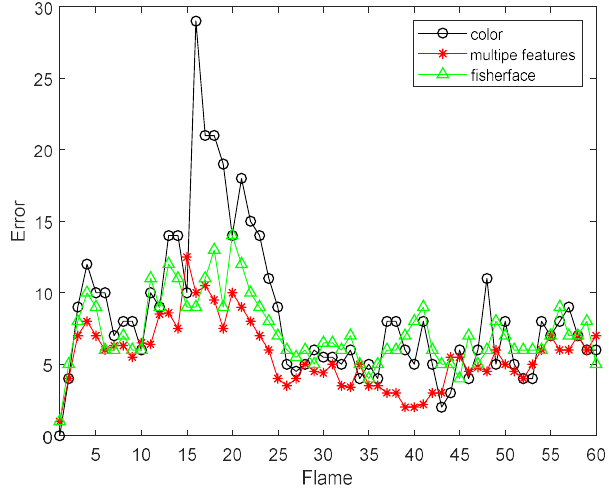
Figure 21. The RMSE comparison corresponding with Fisherface.